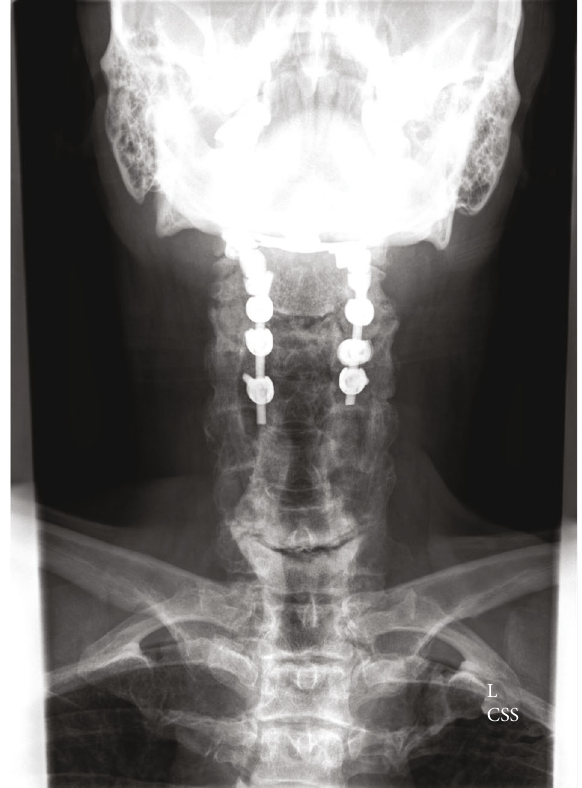
Figure 3: Postoperative anterior cervical spine X-ray demonstrates occipitocervical fusion with a C2-C4 lateral mass screw and posterior rod construct with the occipital